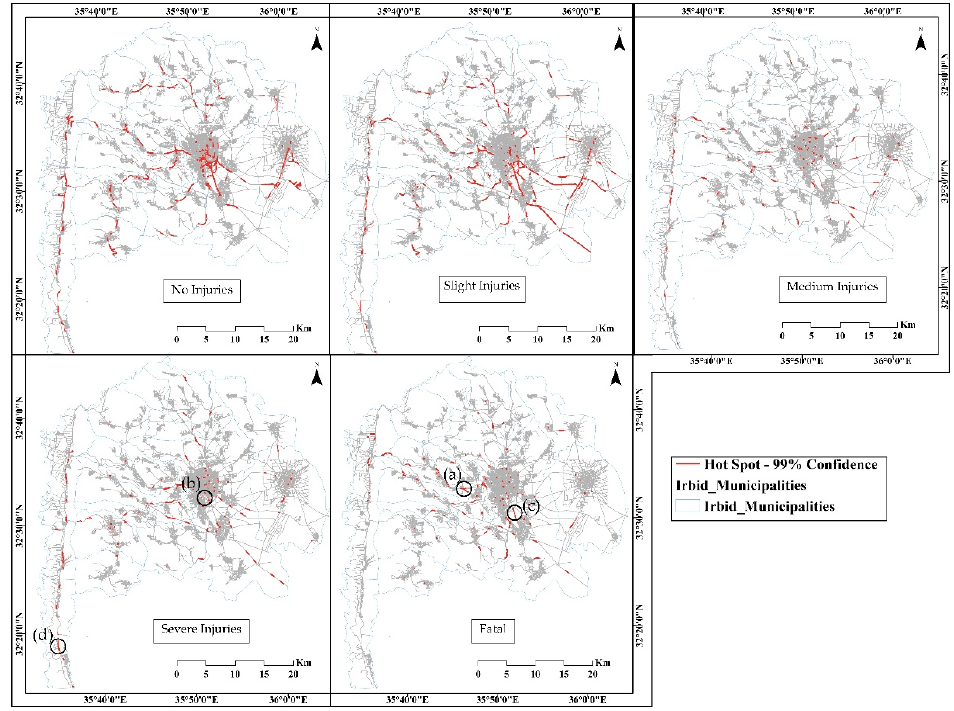
Figure 9. The spatiotemporal geographic distribution maps of traffic-accident hotspots at the sever- ity level from 2015–2019. The lettered circles represent the location of the maps presented in Figure 10a–d.